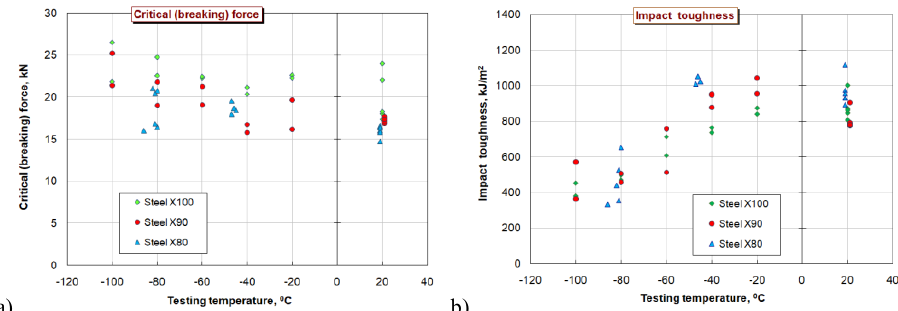
Fig. 4 . Comparison of the critical forces (a) and impact toughness (b) of specimens with an annular V-notch under tension.